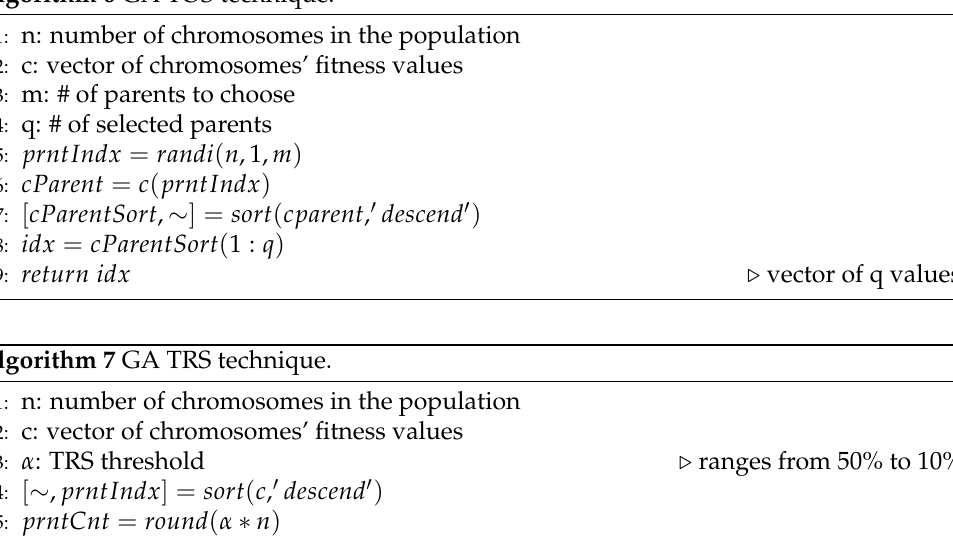
Algorithm 6 GA TOS technique.